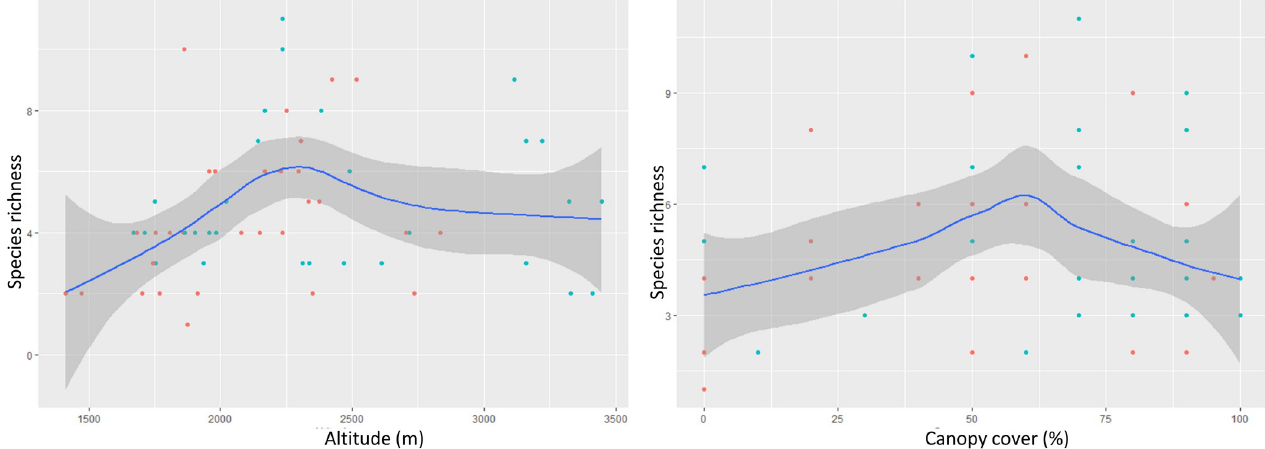
Fig 3. Graph presenting species richness in protected and non-protected forest ranges of Darjeeling district. (a) Species richness maximum at mid elevation of ~2200m (b) Species richness maximum at intermediate cover of ~60% with 95% confidence interval.